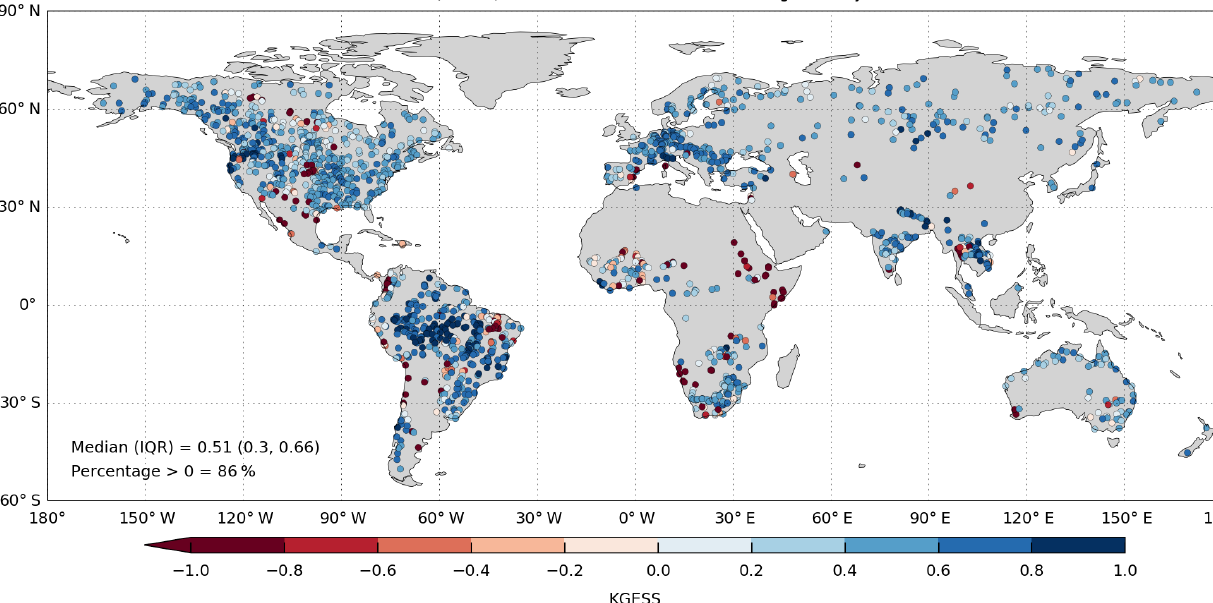
Figure 5. Modified Kling–Gupta efficiency skill score (KGESS) for GloFAS-ERA5 river discharge reanalysis against 1801 observation stations. Optimum value of KGESS is 1. Blue (red) dots show catchments with positive (negative)